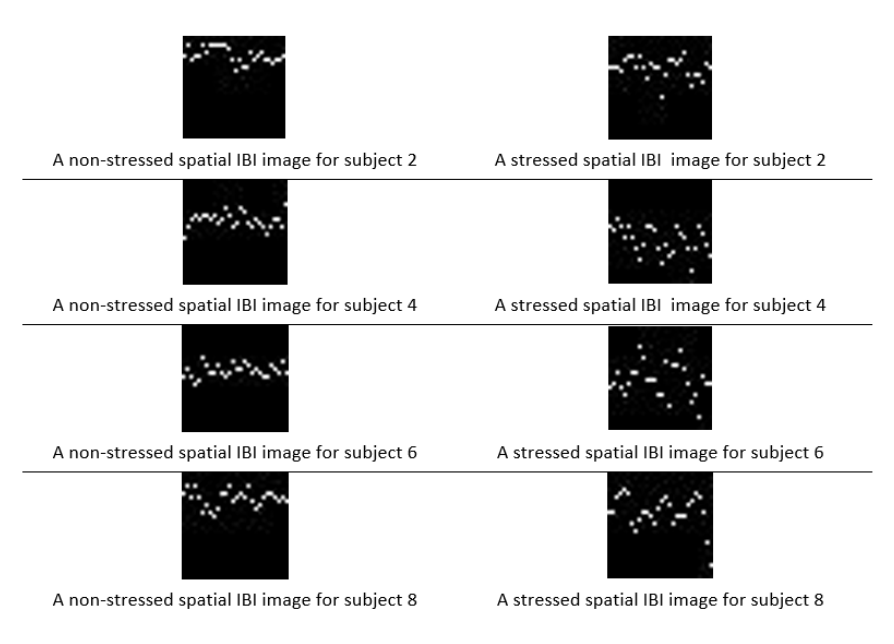
Figure 3. Stressed and non-stressed spatial images for several subjects. Table 1. The mean of all the pixel values in the entire spatial images (image